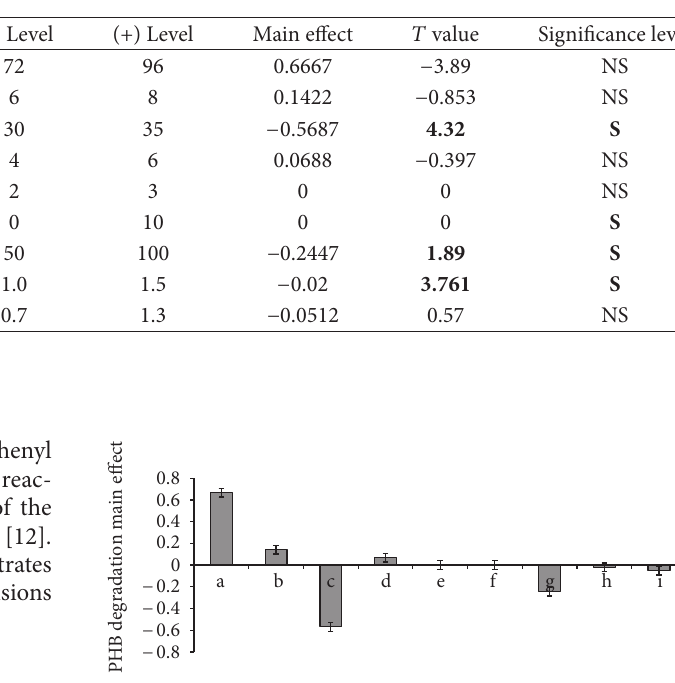
F 1: Elucidation of fermentation factors affecting PHB depoly- merase activity of F. solani